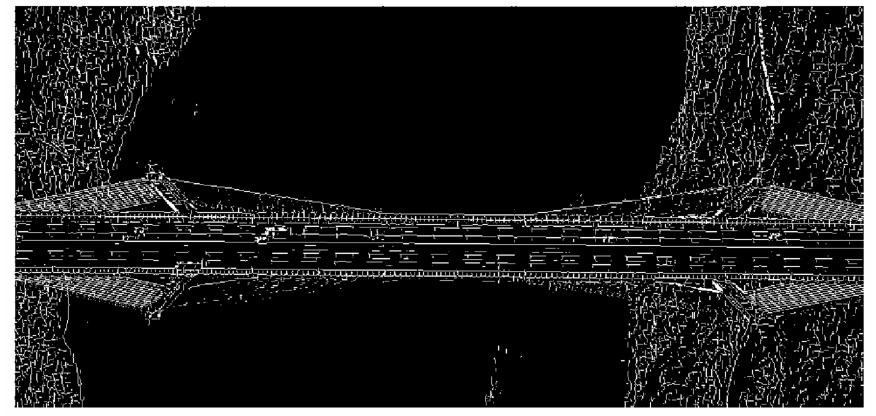
Figure 9. Edge detection results.